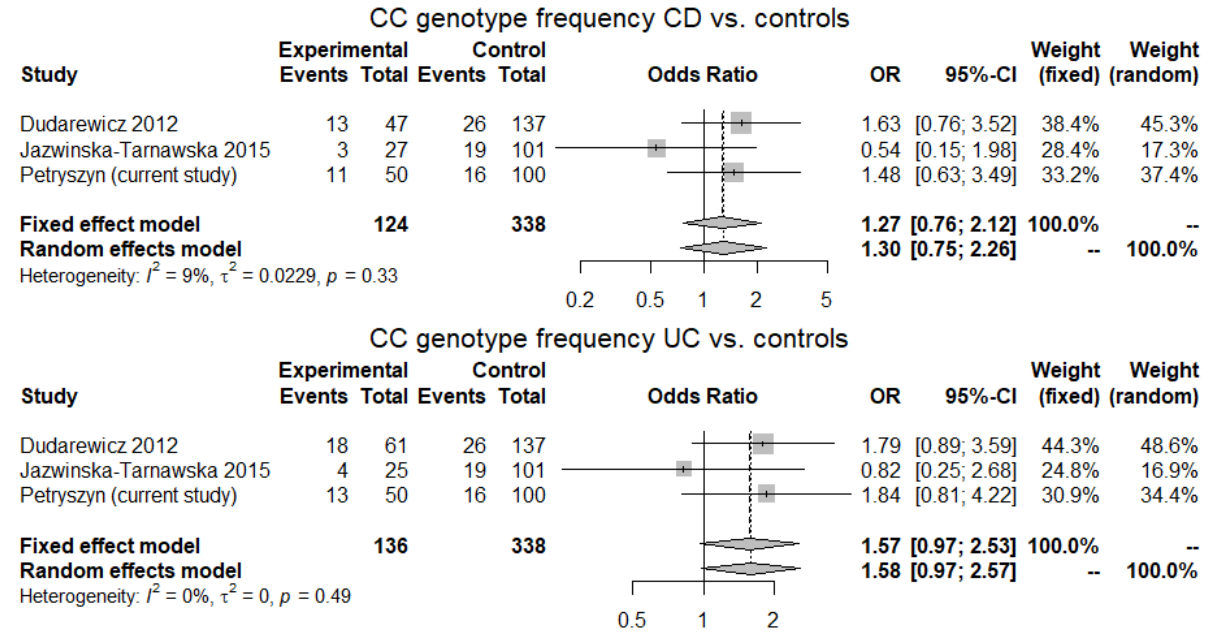
Figure 2. CC genotype frequency in CD and UC patients vs. controls. Three studies examining an association of C3435T polymorphism of ABCB1 gene with IBD in the Polish population with a total of 124 CD cases, 136 UC cases and 338 controls were included. Heterogeneity was low at I 2 = 0–9% ( p > 0.05). Two studies produced a study-specific OR > 1 for CC genotype both for CD and UC and the pooled OR for CC genotype in UC tended to be significant (1.57, 95% CI 0.97–2.53; p = 0.06 and 1.58, 95% CI 0.97–2.57; p = 0.06, for fixed- and random-effects models, respectively).